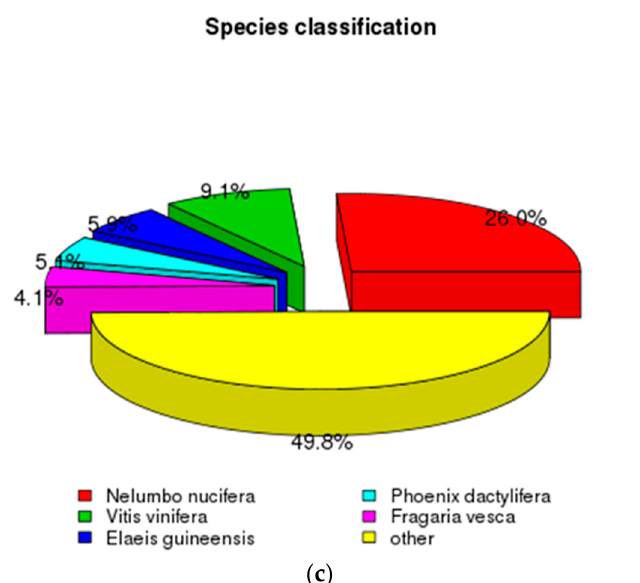
Figure 1. Characteristics of transcripts and unigenes. ( A ) Transcript and unigene length distributions. ( B ) E -value distribution of top BLASTX matches per unigene. ( C ) Distribution of top-matching species for each unigene from BLASTX comparisons of avocado sequences with other plant species.